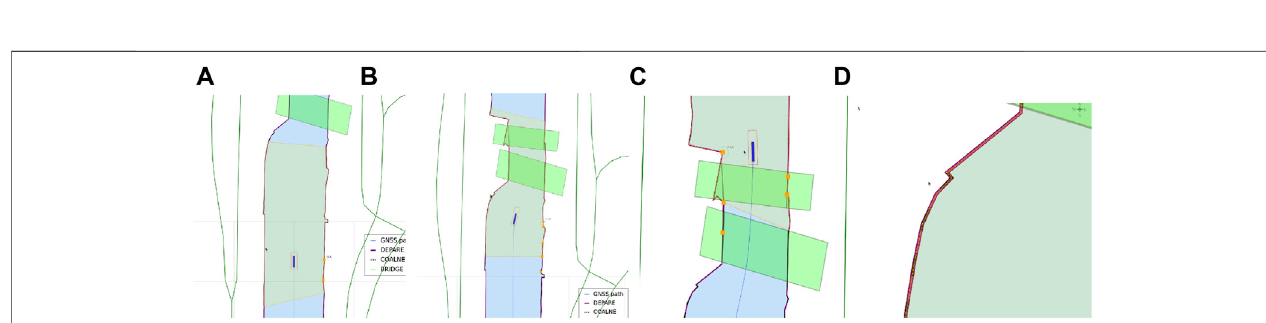
FIGURE 11 | Anticipation domain declaration, i.e., the zone in which obstacles should be detected (within the navigation bounds of the map), of SD2 via a main cartoceptive geometry – geometry relation.